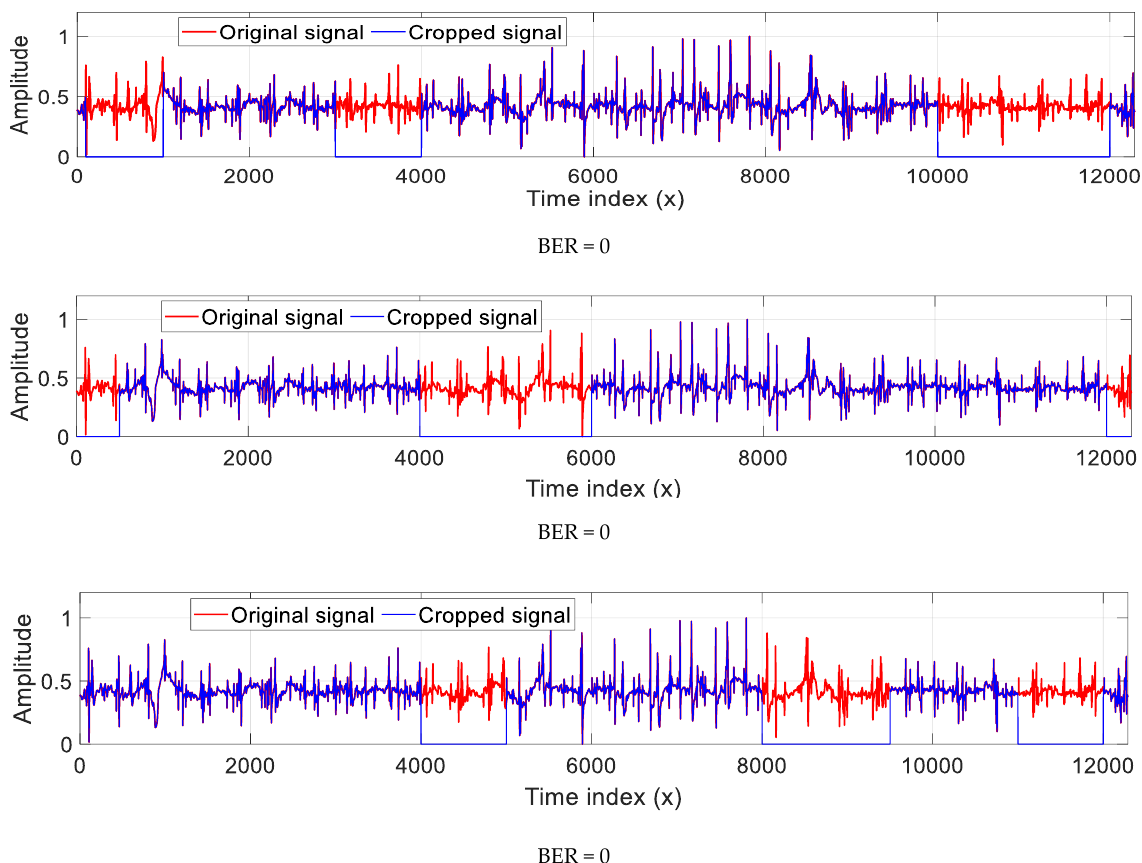
Figure 18. Original EMG signal and its cropped versions with the corresponding BER values.